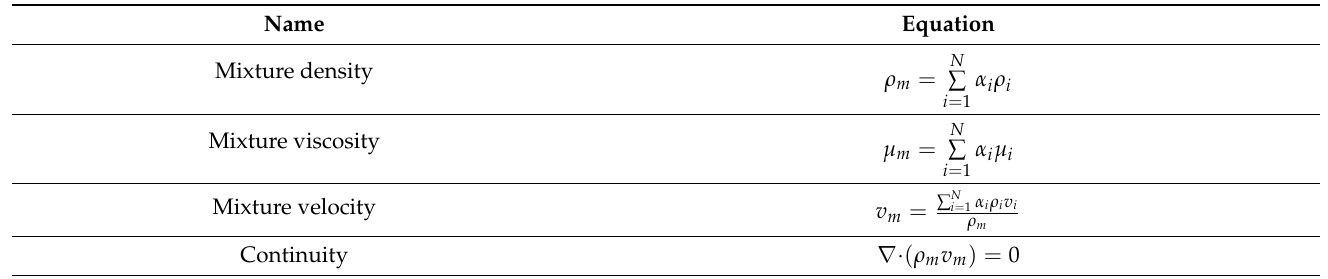
Table 3. Governing